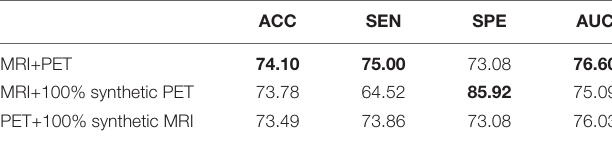
TABLE 10 | The sMCI vs. pMCI classification experiment uses synthetic full data and real full data.